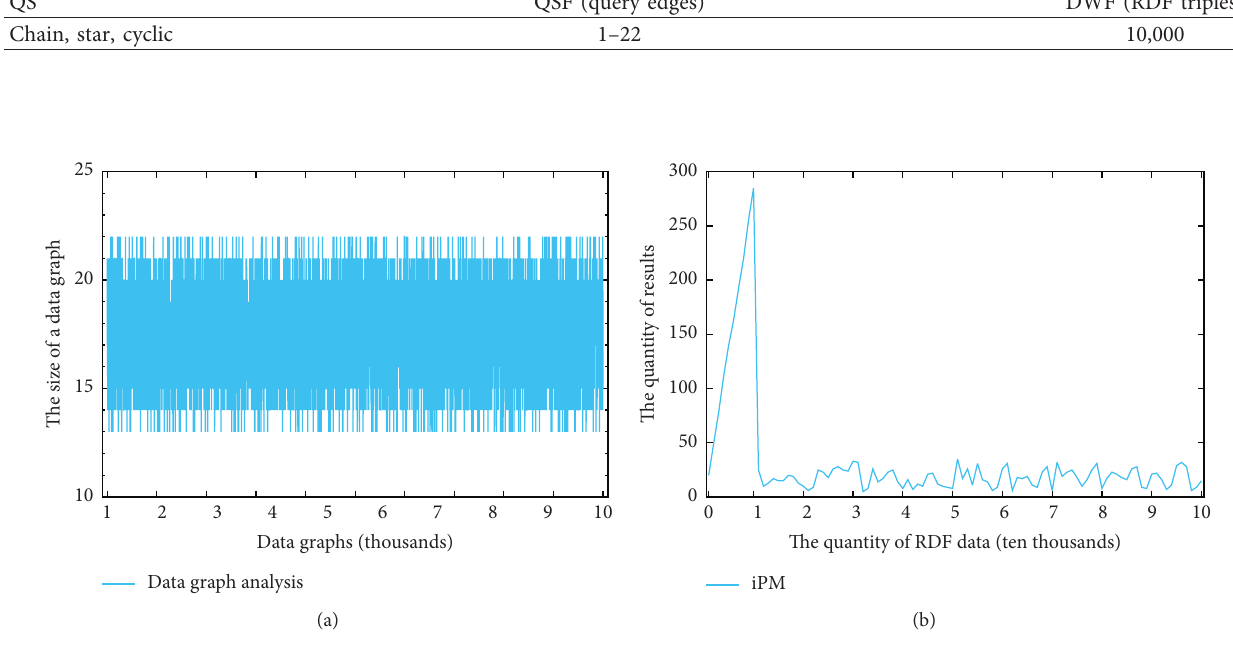
Figure 8: Analysis of (a) data graphs and (b) subgraph